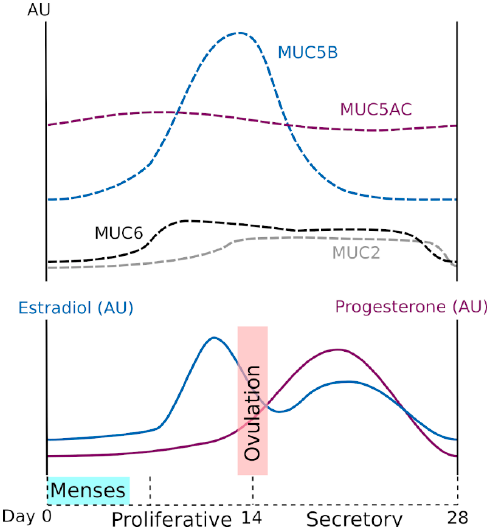
Figure 3. Hormonal regulation of GFMs in the woman’s genital tract. MUC5B was the main GFM in the woman’s genital tract, and its expression peaked at midcycle. MUC5AC was highly expressed and appeared to have little variation through the menstrual cycle. MUC6 and MUC2 were detected in small amounts. MUC6 was observed during the proliferative and secretory phases, and MUC2 during the secretory phase. AU, arbitrary units.